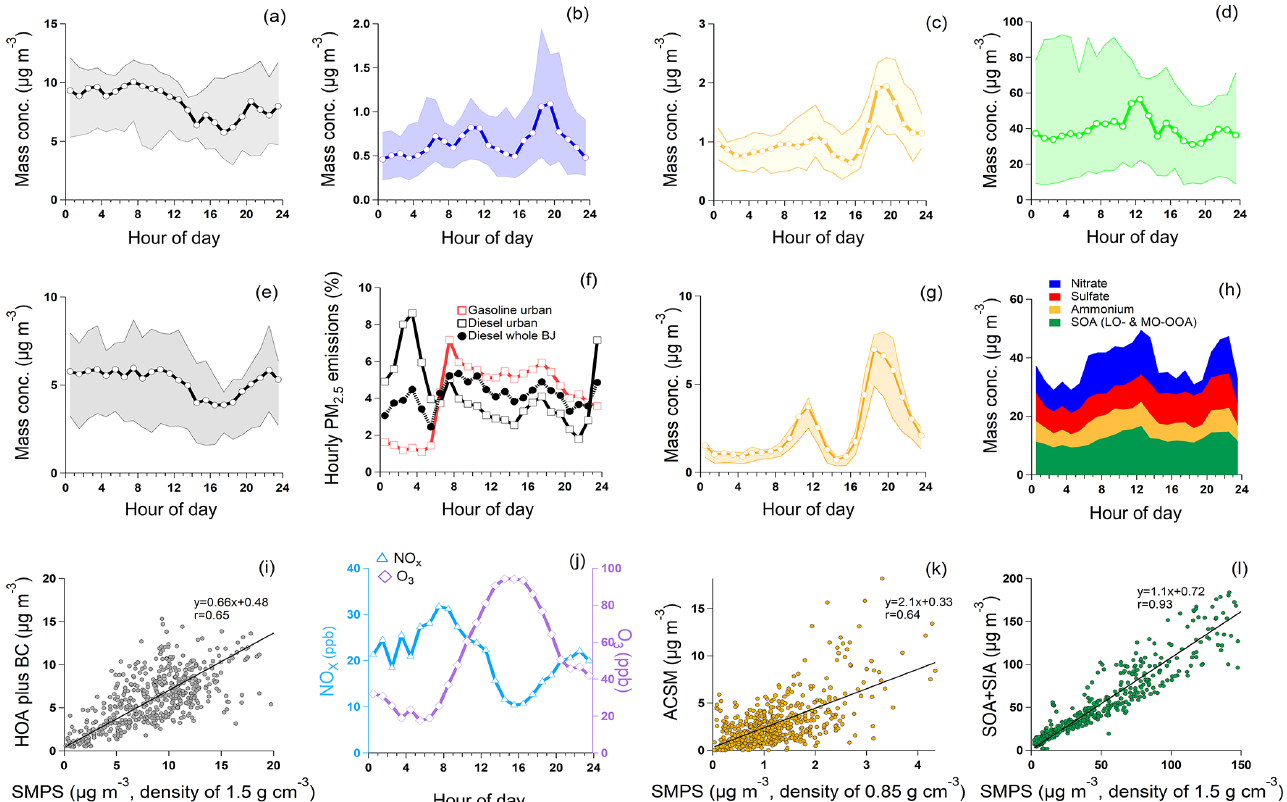
Figure 8. Median diurnal patterns of (a) traffic-ultrafine particles resolved from size PMF, (b) traffic-fine particles from size PMF, (c) cooking-related particles resolved from SMPS and (d) regional-related sources from SMPS. (e) Simulated hourly variation of PM 2 . 5 emis- sions from different traffic types. For each traffic type, the proportions are calculated from hourly emissions divided by the whole day emissions of its type; red and black lines represent gasoline and diesel vehicles in urban Beijing, respectively, and dashed black lines repre- sent diesel vehicles in the whole Beijing area, (f) HOA plus BC from ToF-ACSM and aethalometer. (g) COA from ToF-ACSM. (h) Secondary from ToF-ACSM. (i) NO x (blue line) and O 3 (purple line). (j) Comparison between HOA plus BC and traffic-fine particles. (k) Compari- son between COA and cooking-related particles. (l) Comparison between secondary species from ACSM and regional-related sources from SMPS. Shaded areas are the 25th and 75th